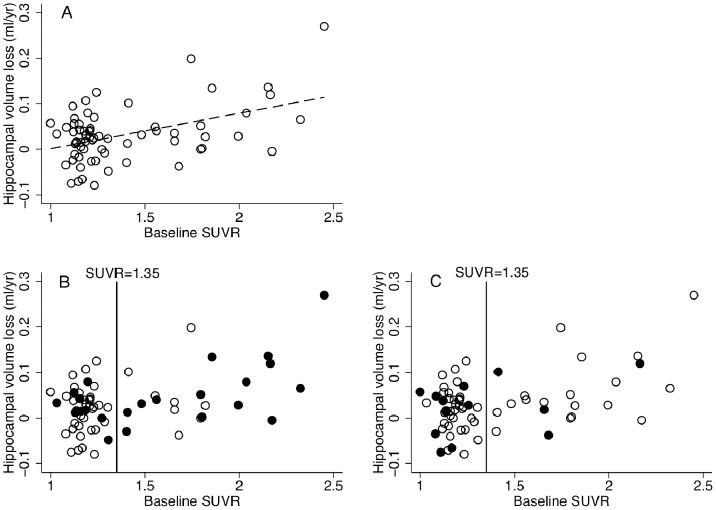
Plots of baseline SUVR vs. annualized hippocampal change.(A) The relationships and regression slope for the group as a whole; (B) APOE4 individuals shown in closed circles; (C) subjective cognitive impairment individuals shown in closed circles. SUVR values between 1.31 and 1.40 separate the groups: a reference line at SUVR = 1.35 is shown for illustration.